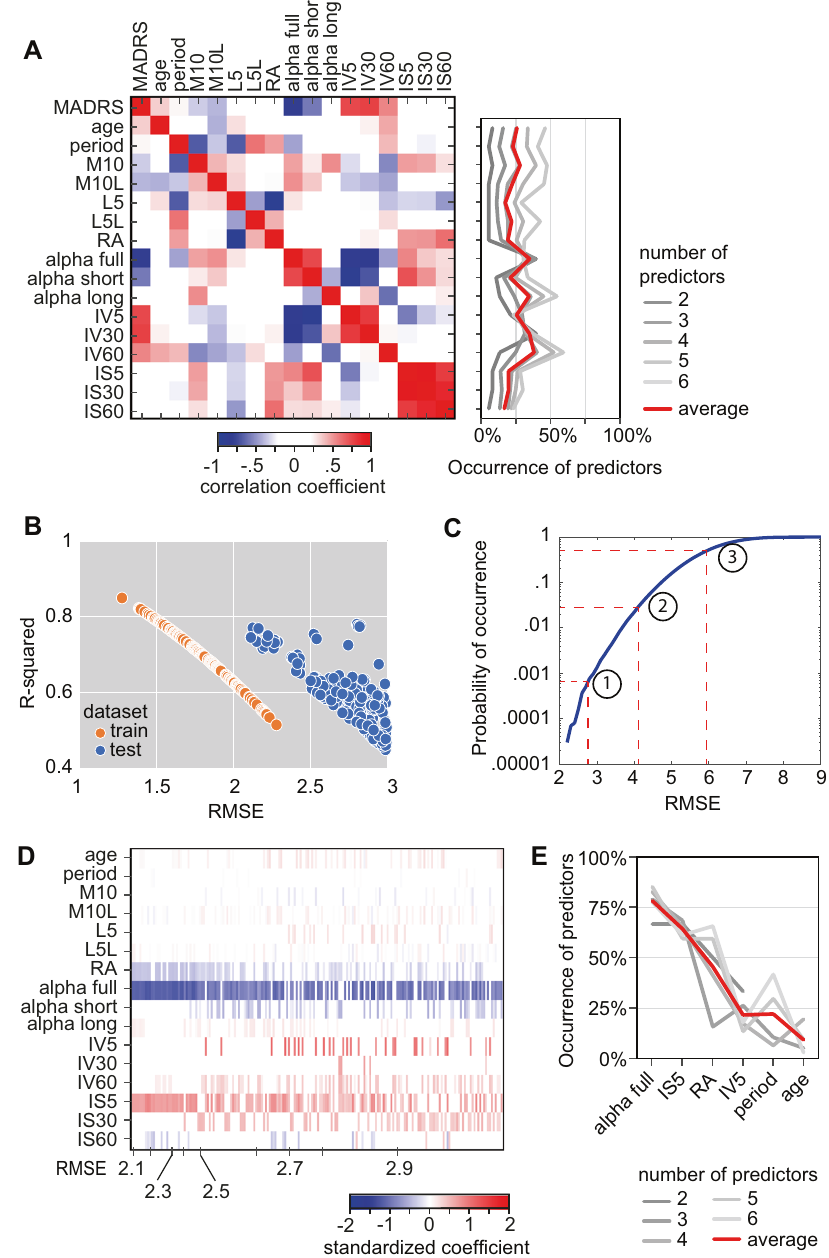
Fig. 2 Development of multiple regression models by brute force. A Correlation matrix for all predictors used for model training (training dataset only). The occurrence of individual predictors in the models surviving internal validation is depicted in the right panel. B Performance of models surviving external validation ( N = 192) on train and test (independent) datasets. C Cumulative histogram of accuracy (RMSE) achieved by 1 million simulated random datasets with overlayed reference values: (1) average RMSE for models surviving external validation; (2) accuracy level of dummy model; (3) average accuracy of simulated datasets. D Standardized coef fi cients for all models surviving external validation criteria ( N = 192), sorted by RMSE on test dataset in ascending order. Each model is depicted by one column and corresponds to a point in the scatterplot in ( B ). E Occurrence of most frequently encountered individual predictors the models surviving external validation criteria. “ period ” and “ age ” are included based on potential biological occurrence below 0.001 (Fig. 2C). The analysis of standardized Next, we evaluated the performance of models surviving coef fi cients for the models surviving external validation revealed internal validation in predicting the MADRS score in an good consistency across models for most independent predictors independent population. The fi ltering criteria for external valida- (Fig. 2D). We further found that alpha full, IS5, and RA were tion further reduced the number of validated models to 192 included on average in >50% of the models (Fig. 2E). (Fig. 2B). The average RMSE and R -squared in the models surviving These results indicate that depression severity scores correlate external validation were 2.70 ± 0.24, and 0.59 ± 0.09, respectively. with features extracted by analyzing the pattern of activity In comparison with the simulated dataset, the average RMSE for recorded over several consecutive days. The brute force approach validated models corresponds to models with a probability of